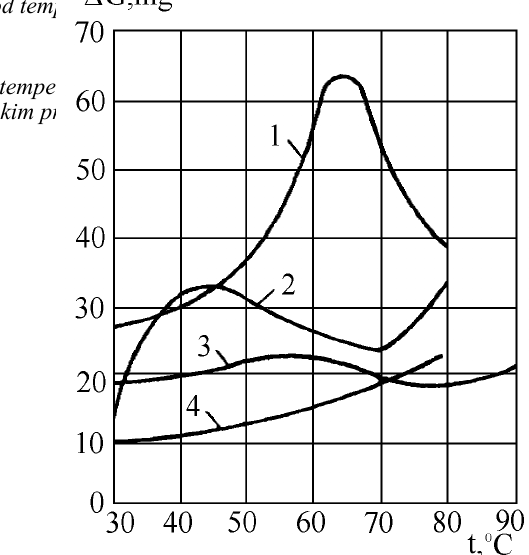
Sl. 6 – Zavisnost kavitacionih razaranja od temperature vode visoke ~isto}e pri konstantnim hidrostatskim